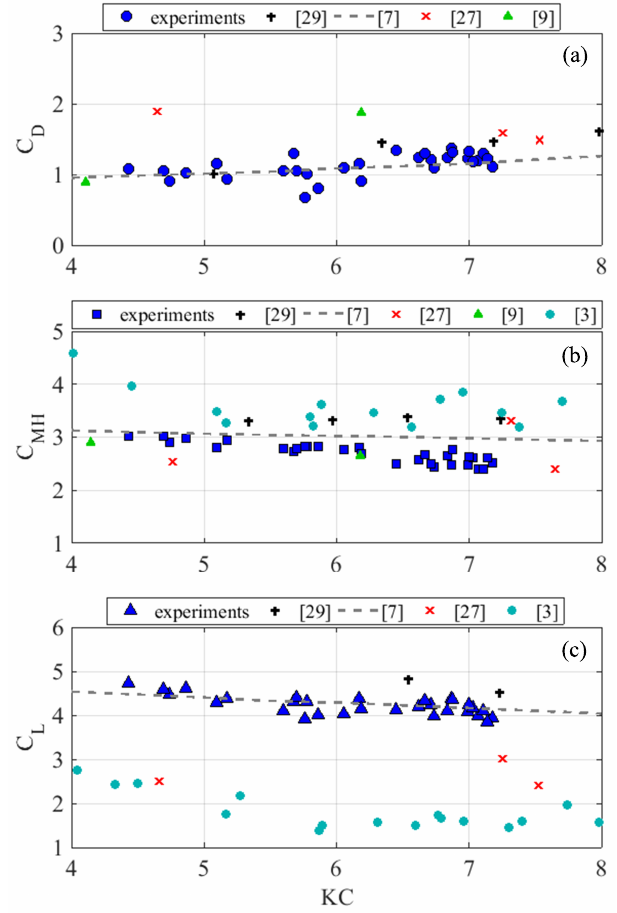
Figure 9. Experimental hydrodynamic coefficients vs. KC and comparison with literature coefficients for regular waves. ( a ) C D ; ( b ) C MH ; ( c ) C L